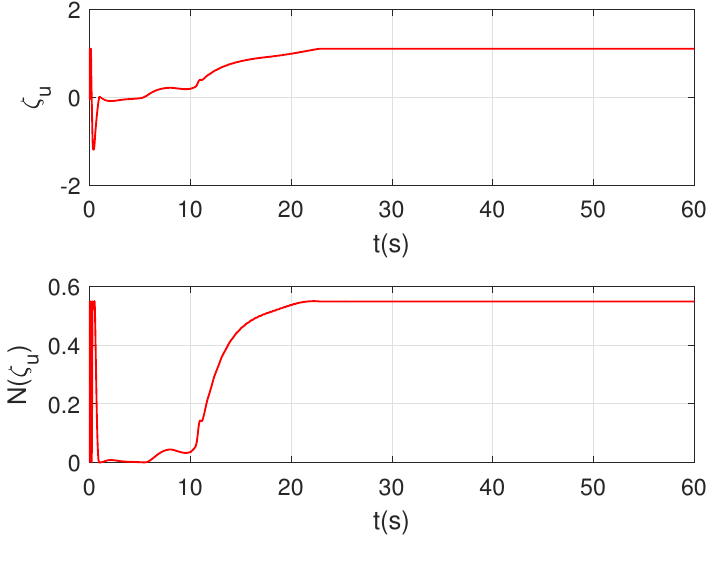
Figure 9. Nussbaum parameters.